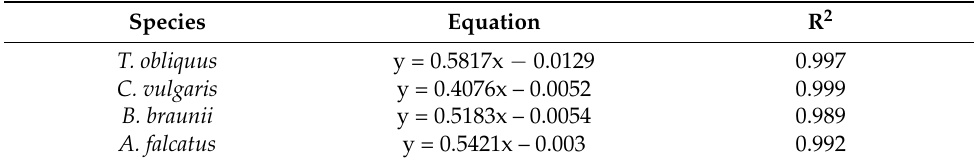
Table 2. Calibration curves: optical density (OD 680 ) to biomass dry weight (g L − 1